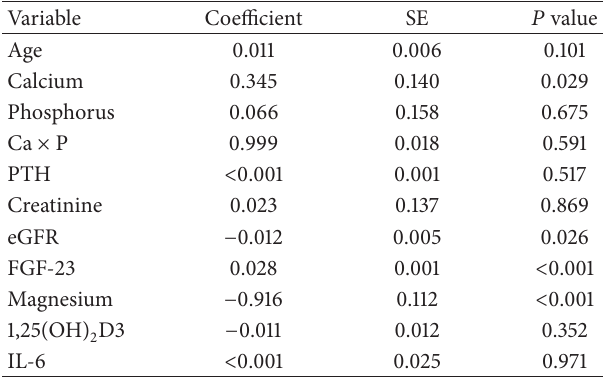
Table 3: Multivariate linear regression analysis of influencing factors of mitral valve